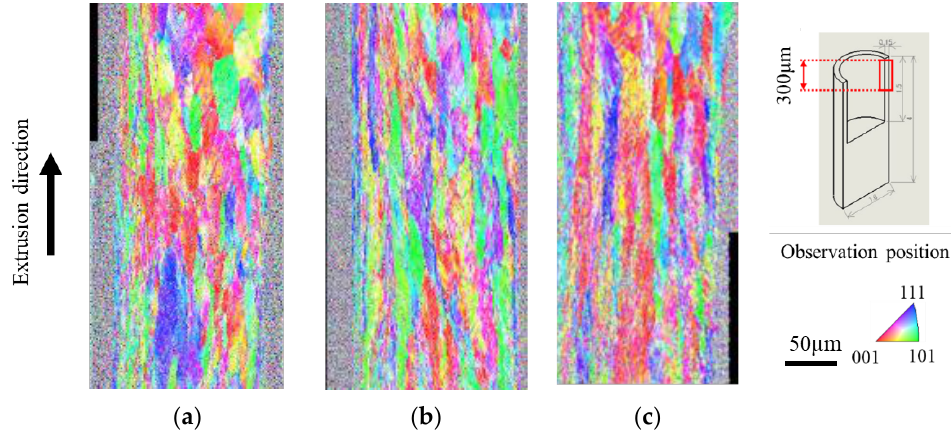
Figure 7. IPF map of the extrusion obtained using EBSD: ( a ) mirror surface, ( b ) 5 μm -textured, and ( c ) nanometer-textured punches.